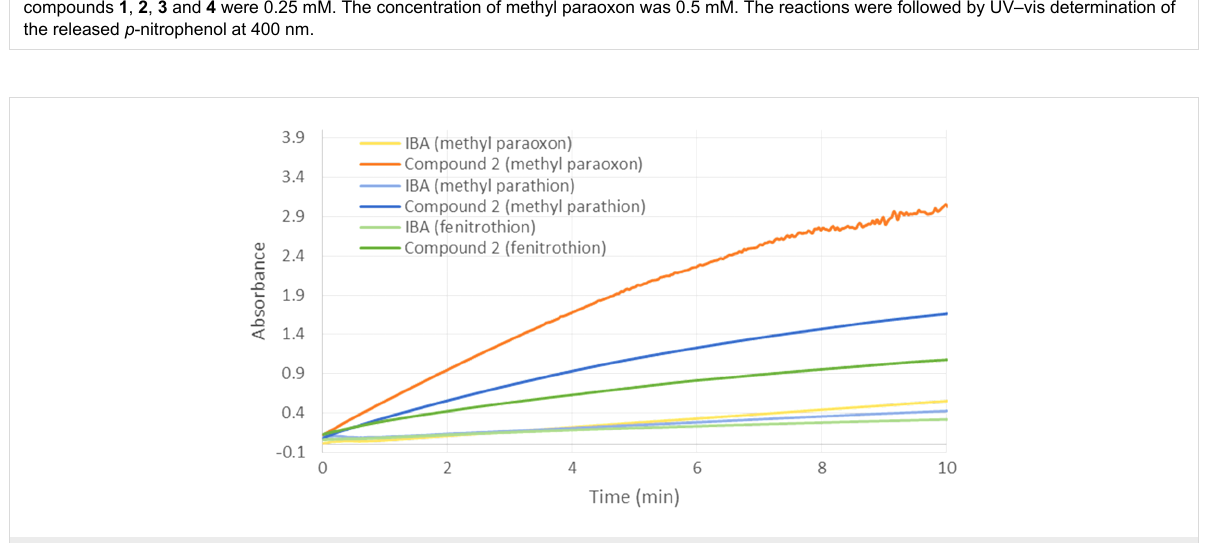
Figure 9: Influence of the pesticide structure on the hydrolytic efficiency of compound 2 (0.25 mM). Kinetic assays were carried out with methyl paraoxon, methyl parathion or fenitrothion (0.5